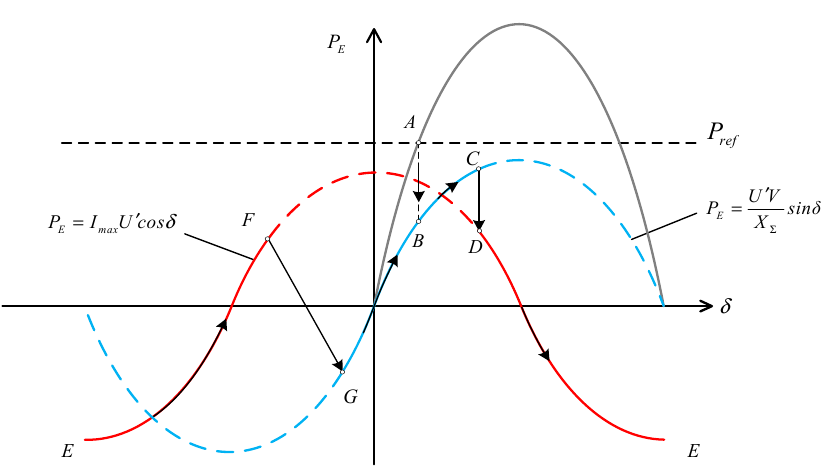
Figure 8. Power angle curve with small line impedance during deep grid voltage sag.